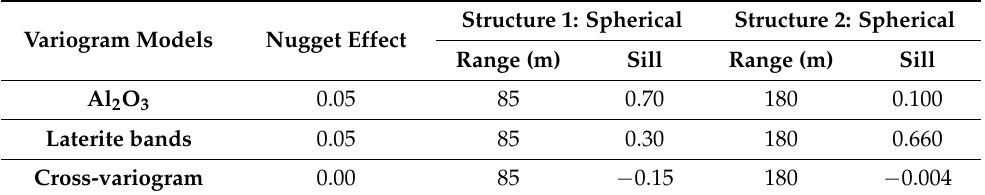
Table 4. Direct and cross-variogram models between Al 2 O 3 and laterite band ratio (data from March–April 2019).